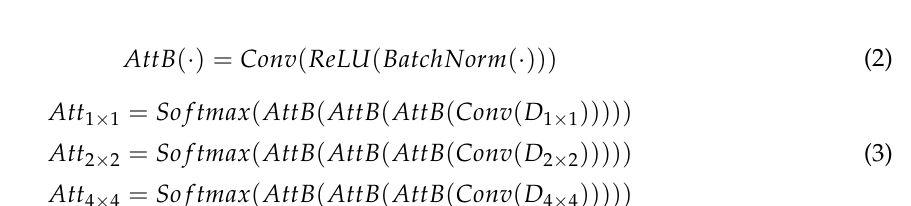
Figure 2. Face-level representation